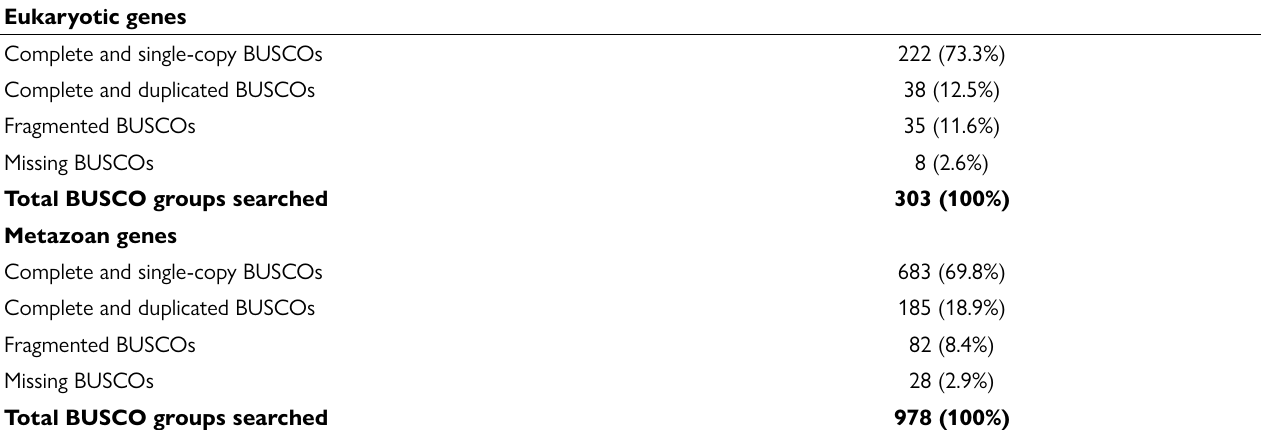
Table 2. Summary of transcriptome completeness assessment by BUSCO